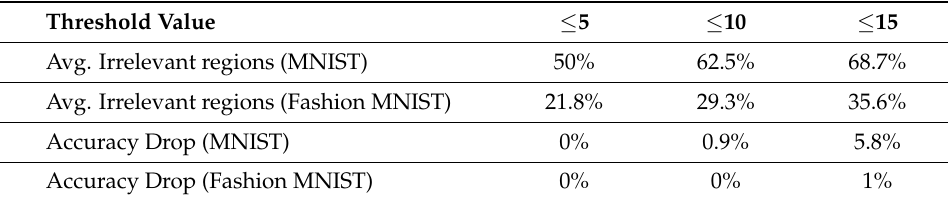
Figure 6. ( a ) An original image in MOT17-SD1 dataset [31] ( b ) Percentage regions with Temporal redundancy in the dataset ( c , d ) image regions without redundancies (effective data volume is very low). Table 2. Impact of Attention Module Threshold (8 × 8 region